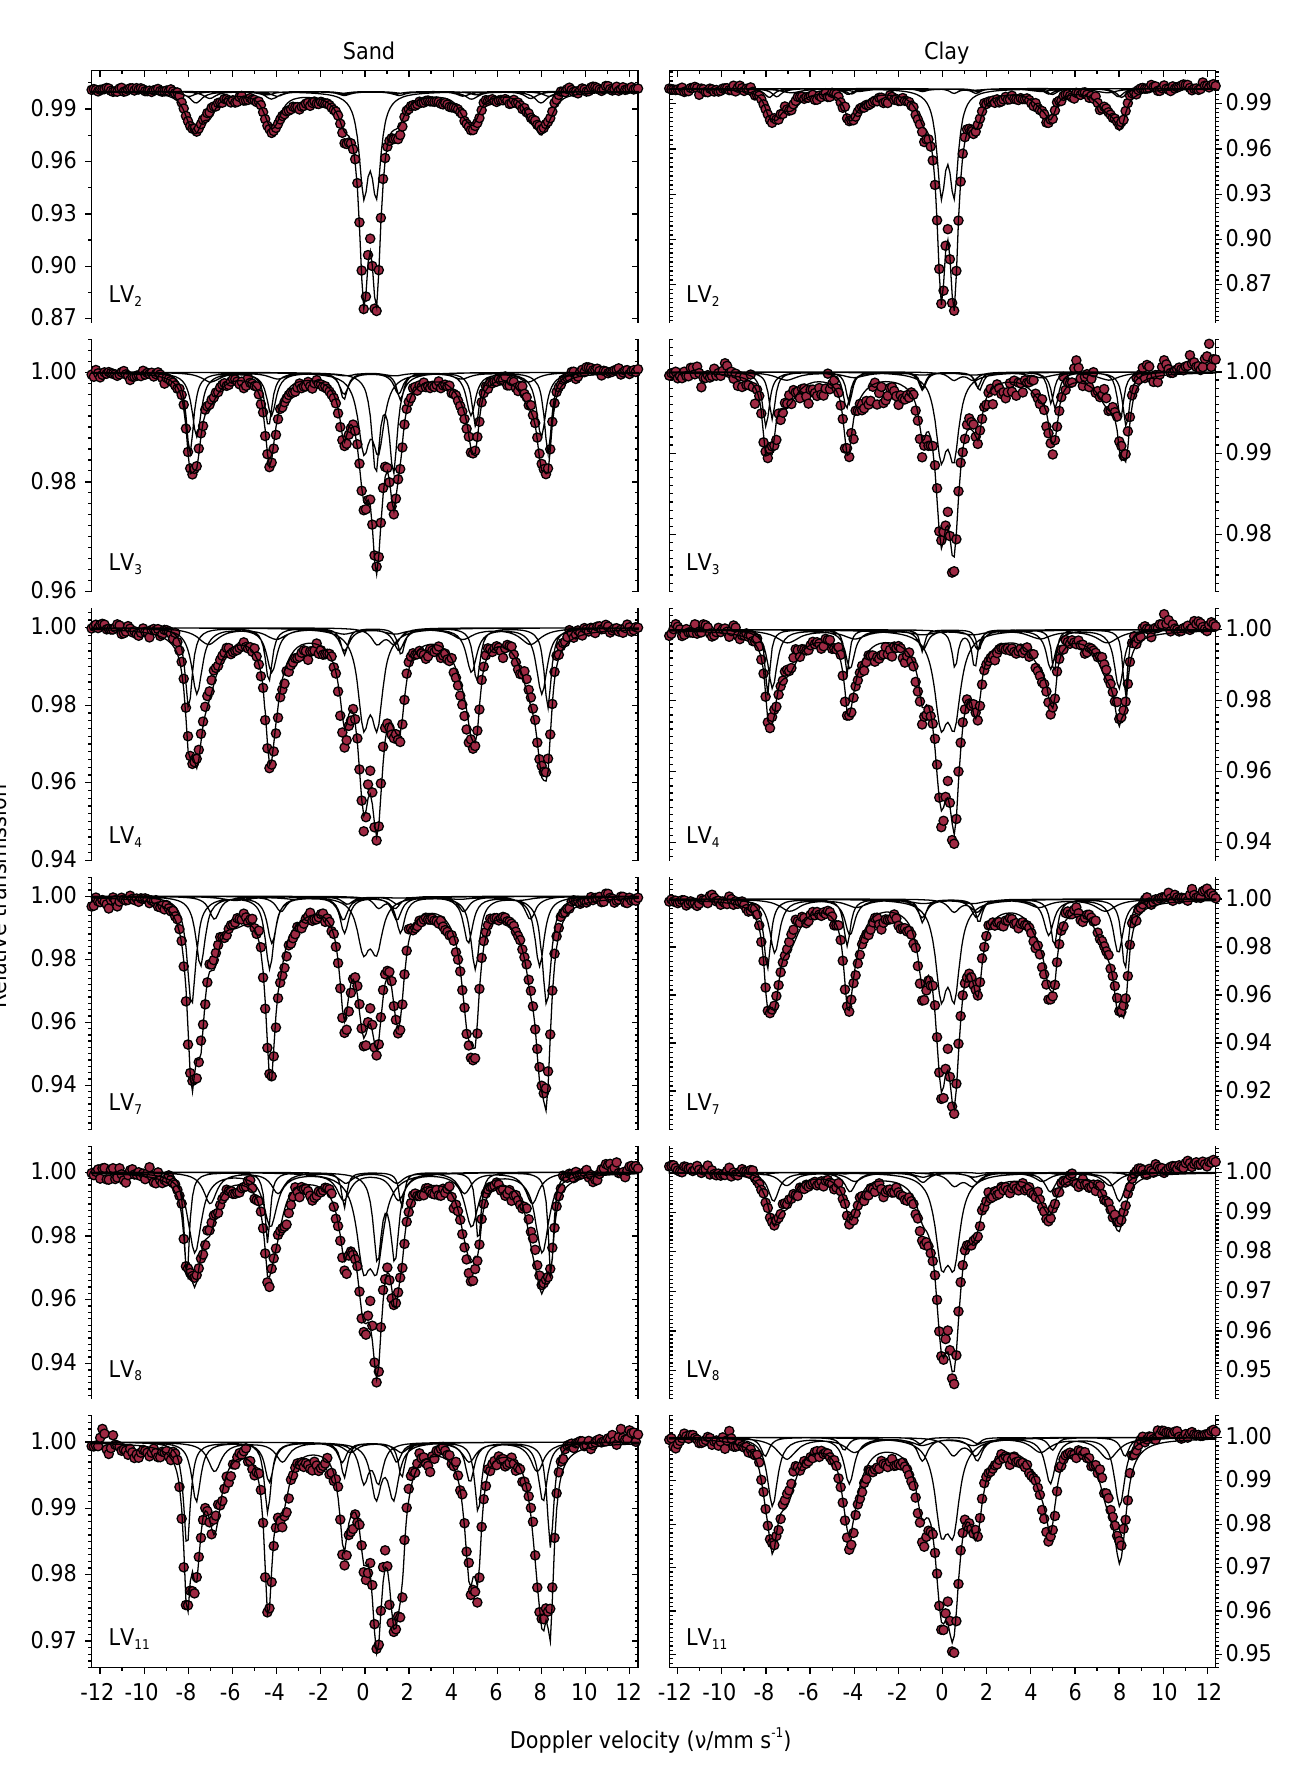
Figure 8. Mössbauer spectra of the sand and clay fractions in selected soils LV 2 , LV 3 , LV 4 , LV 7 , LV 8 , and LV 11